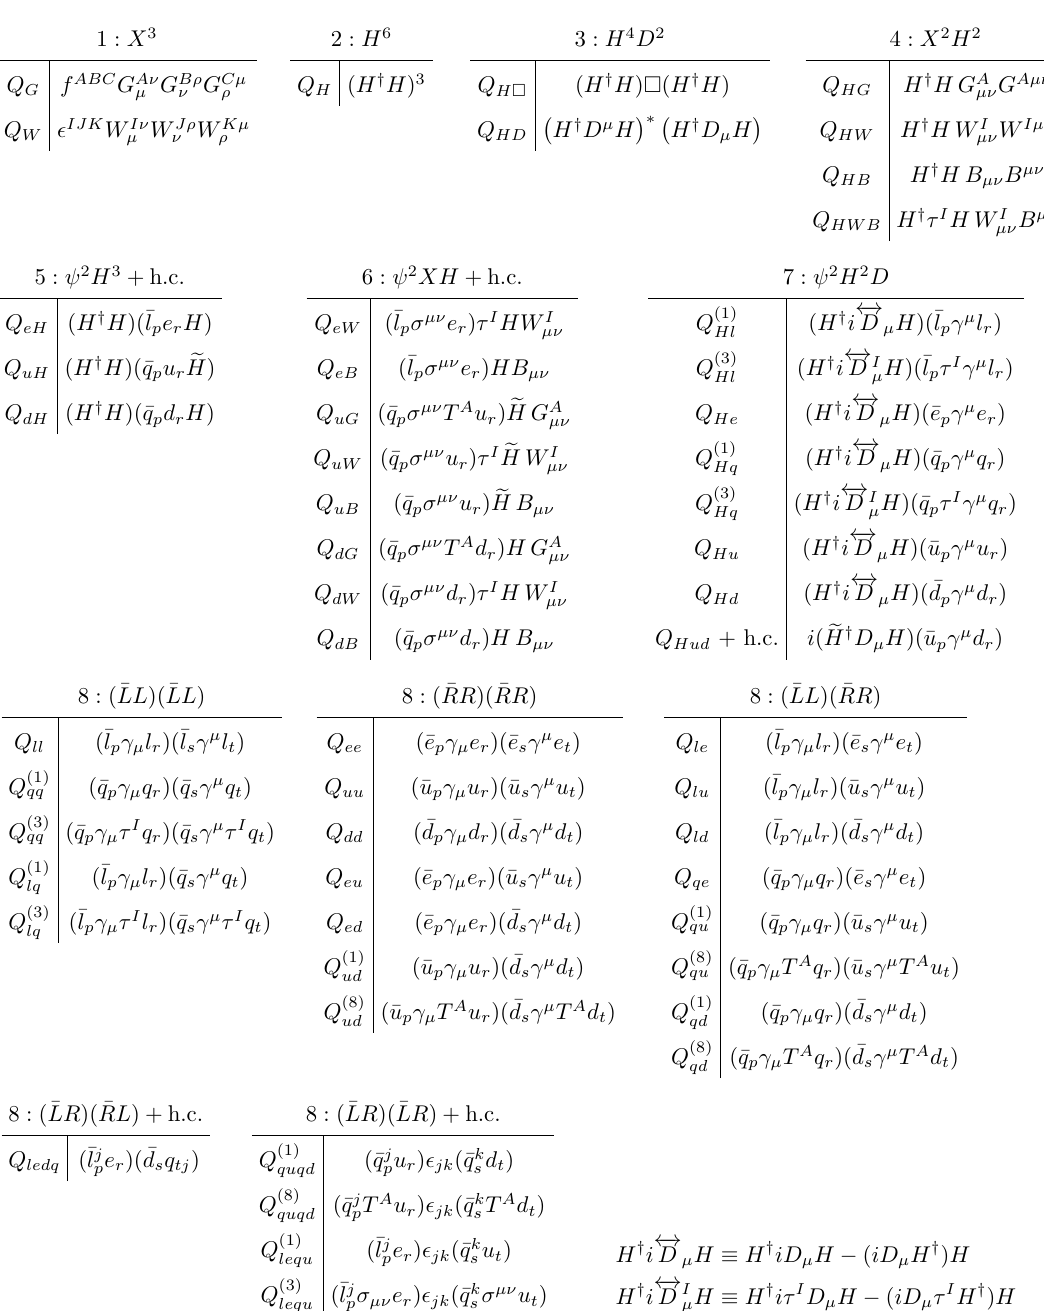
Table 2 . The dimension-six operators of the SMEFT in the Warsaw basis, reproduced from [15]. The CP-violating operators are not included as they are not currently implemented in this package. The operators are divided into eight Classes based on field content, those which are not hermitian are indiced by + h.c. in the left-hand column. p , r , s , and t are used as flavor indices for fermionic operators and are dropped in the operator labels Q